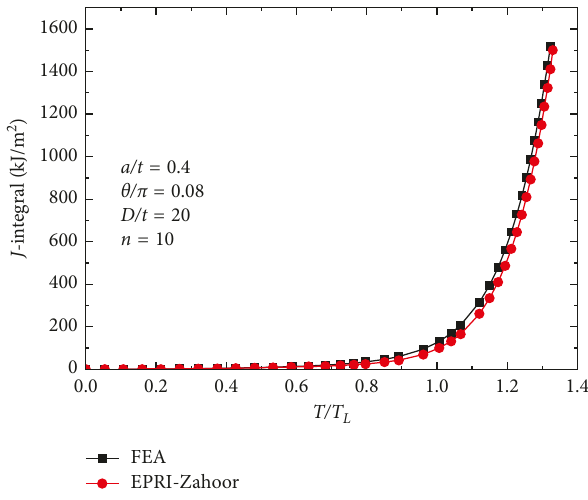
Figure 4: Comparison of J -integral values for relatively thick- walled pipes under tension with D / t